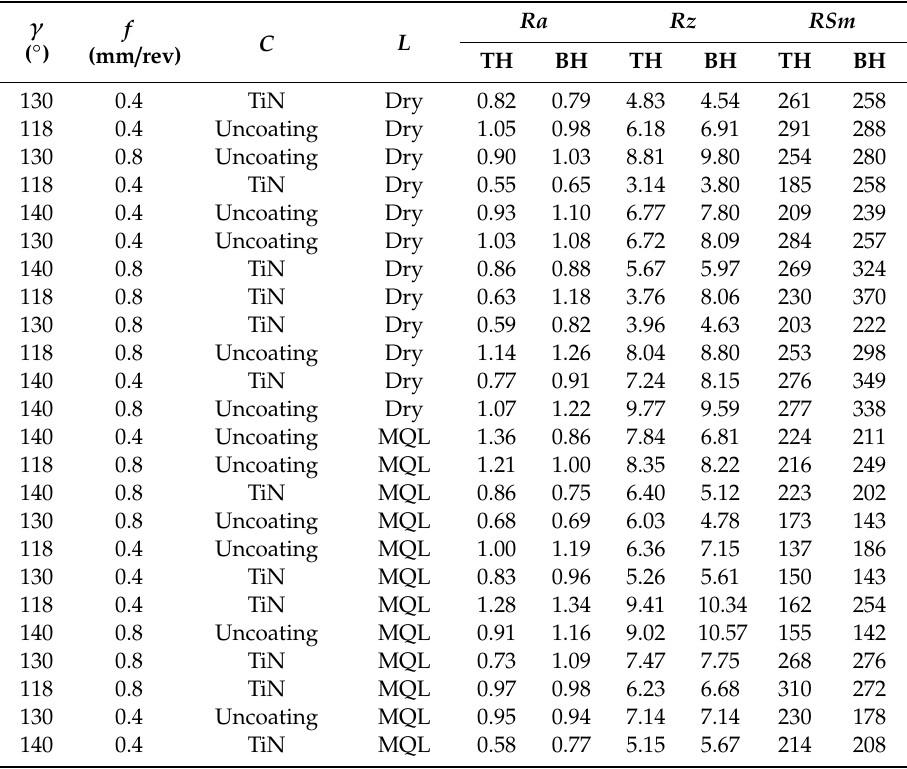
Table 3. Measured Ra , Rz and RSm ( µ m) obtained during the trials at two measurement depths.